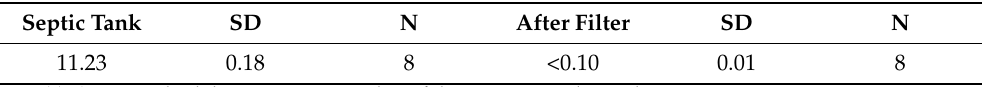
Table 5. Average concentration of surfactants (mg/L) with standard deviation (SD) in the waste water samples from the WWTP ECOair.